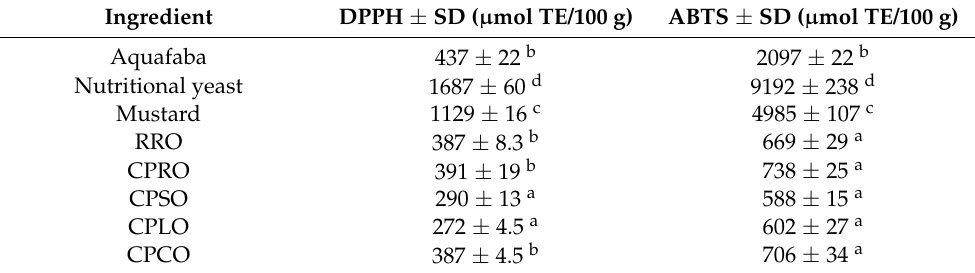
Table 4. Radical scavenging activity of mayonnaise ingredients determined by DPPH and ABTS assays.